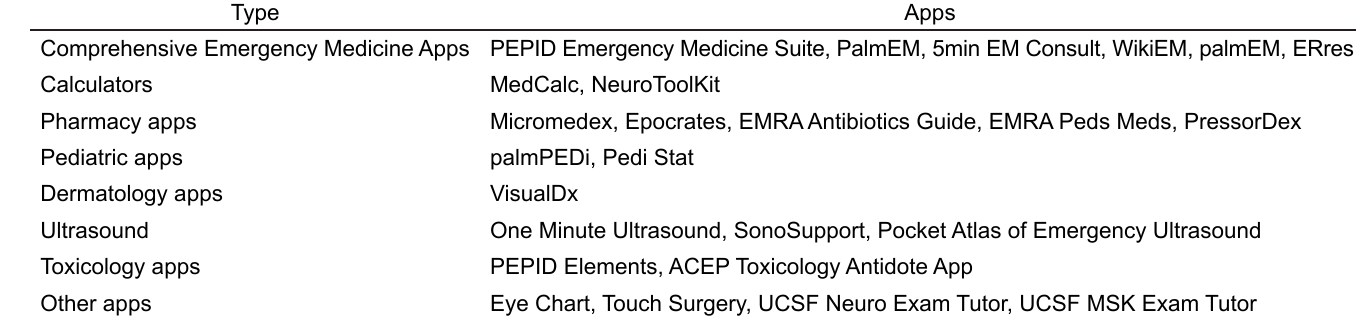
Table 2. Author-recommended